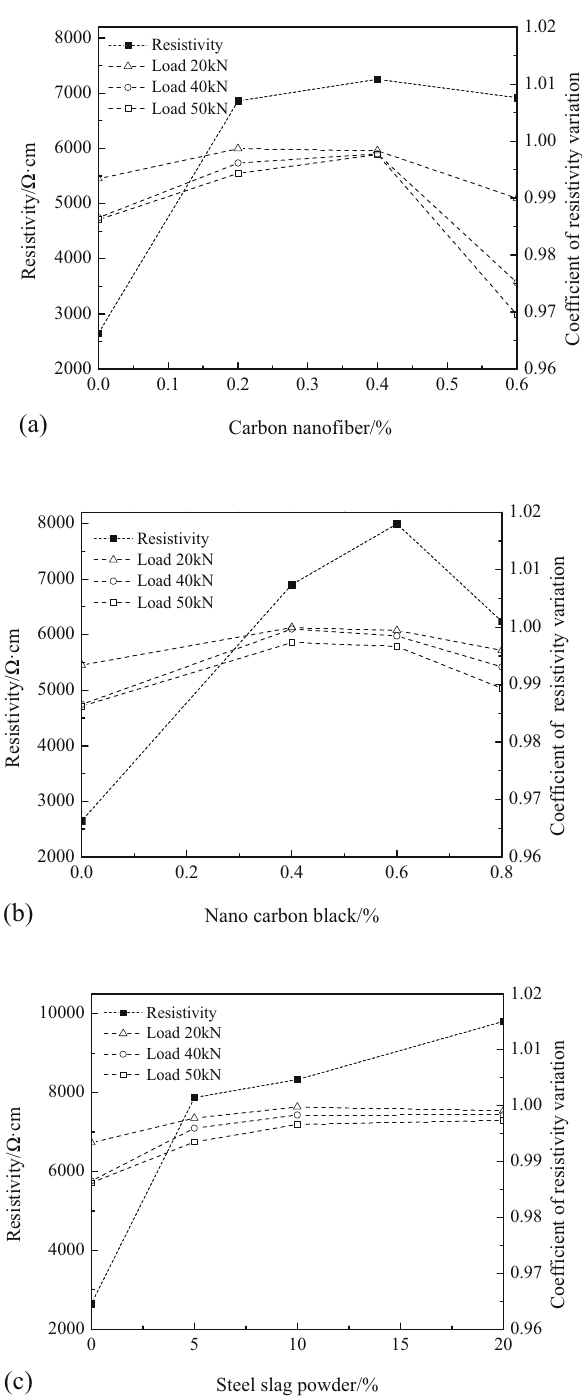
Figure 3: Resistivity and coe ffi cient of resistivity of CFRC under compression loading: ( a ) carbon nano fi ber, ( b ) nano carbon black, ( c ) steel slag